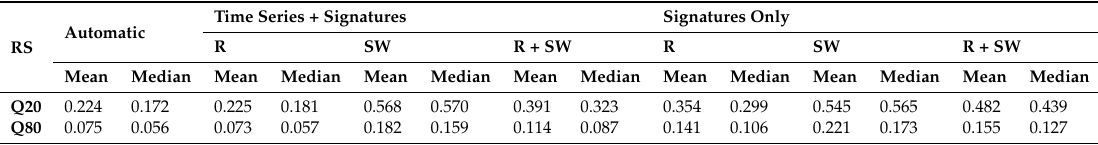
Table 4. Relative difference in Q20 and Q80 for runoff. Automatic, time series + signatures and signatures only mean calibration strategies which combinate runoff (R), soil moisture (SW) or runoff + soil moisture (R + SW).